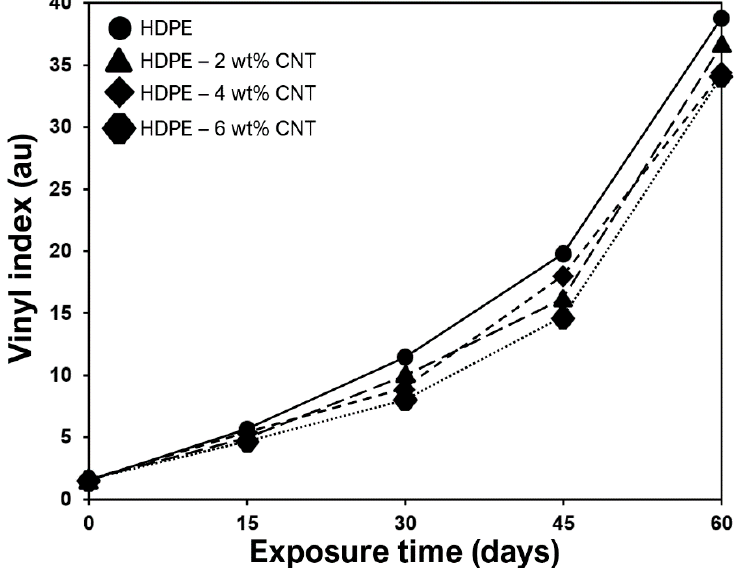
Figure 7. Vinyl indices ((cid:31) CO ) of the monolithic and nanocomposite films exposed to UV-B radiation.